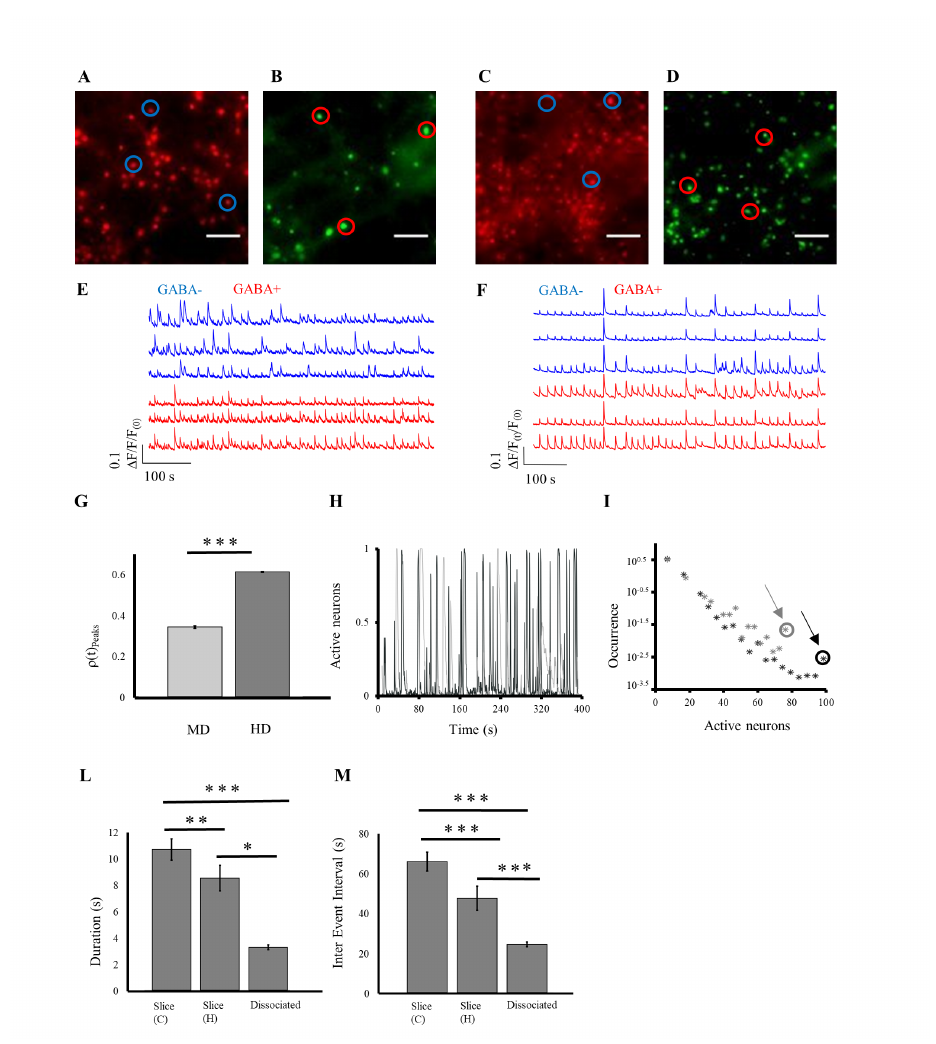
Fig. 5. Dissociated cortical cultures plated at high (HD) and medium (MD) density. (A, C) MD and HD cultures stained with Fura-Red calcium-sensitive dye. (B, D) Corresponding GABA+ neurons in the same field of view. From the neurons in the blue and red circles, the corresponding optical traces ΔF/F (0) are shown in (E, F) : blue and red traces represent GABA- and GABA+ neurons respectively. Scale bars, 80 μm, in all fluorescence images. (G) Average ρ(t) Peak in MD (light gray) and HD (dark gray) cultures; n = 9354(3) pairs of neurons(sample) for HD, n = 1211(3) pairs of neurons(sample) for MD. (H) Activation of neurons over time in MD (gray) and HD (black) cultures, normalized to the total number of neurons (105 and 34 for HD and MD cultures, in this representative experiment). (I) Probability distribution of the number of neurons simultaneously active in MD (gray marks) and HD (black marks) cultures, with corresponding outliers (see circles). ( L, M ) Average duration and IEI (s) of DOTs in cortical (C) and hippocampal (H) slices (same data as in G, H, I) vs dissociated cultures. n = 78(4) DOTs(samples) for dissociated cultures. ⃰ p < 0.51, ⃰ ⃰ ⃰p < 0.001 two-sided Wilcoxon rank-sum